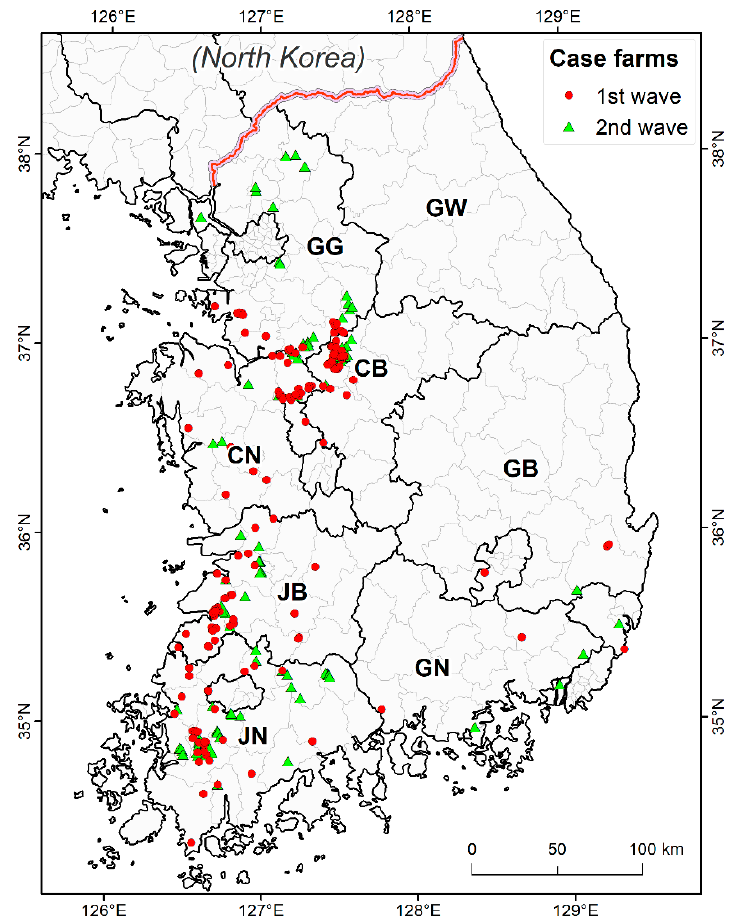
Figure 1. Location of highly pathogenic avian influenza case farms in the first and second waves. Red round dots are the outbreaks in poultry farms during the first wave from 14 January 2014 to 29 July 2014. Green triangles are the outbreaks in poultry farms in the second wave from 23 September 2014 to 24 June 2015. Province abbreviations: CB: Chungbuk, CN: Chungnam, GB: Gyeongbuk, GG: